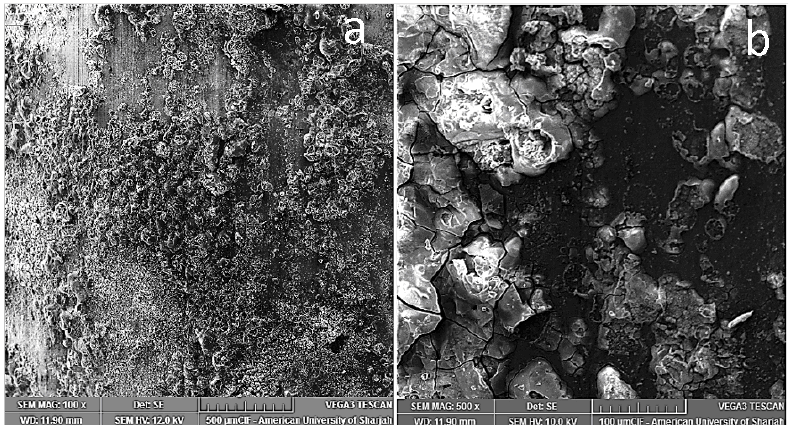
Figure 7. Micrographs depicting corrosion surface morphology. ( a , b ) Mg-1.0 SiO 2 in HBSS at different magnifications.